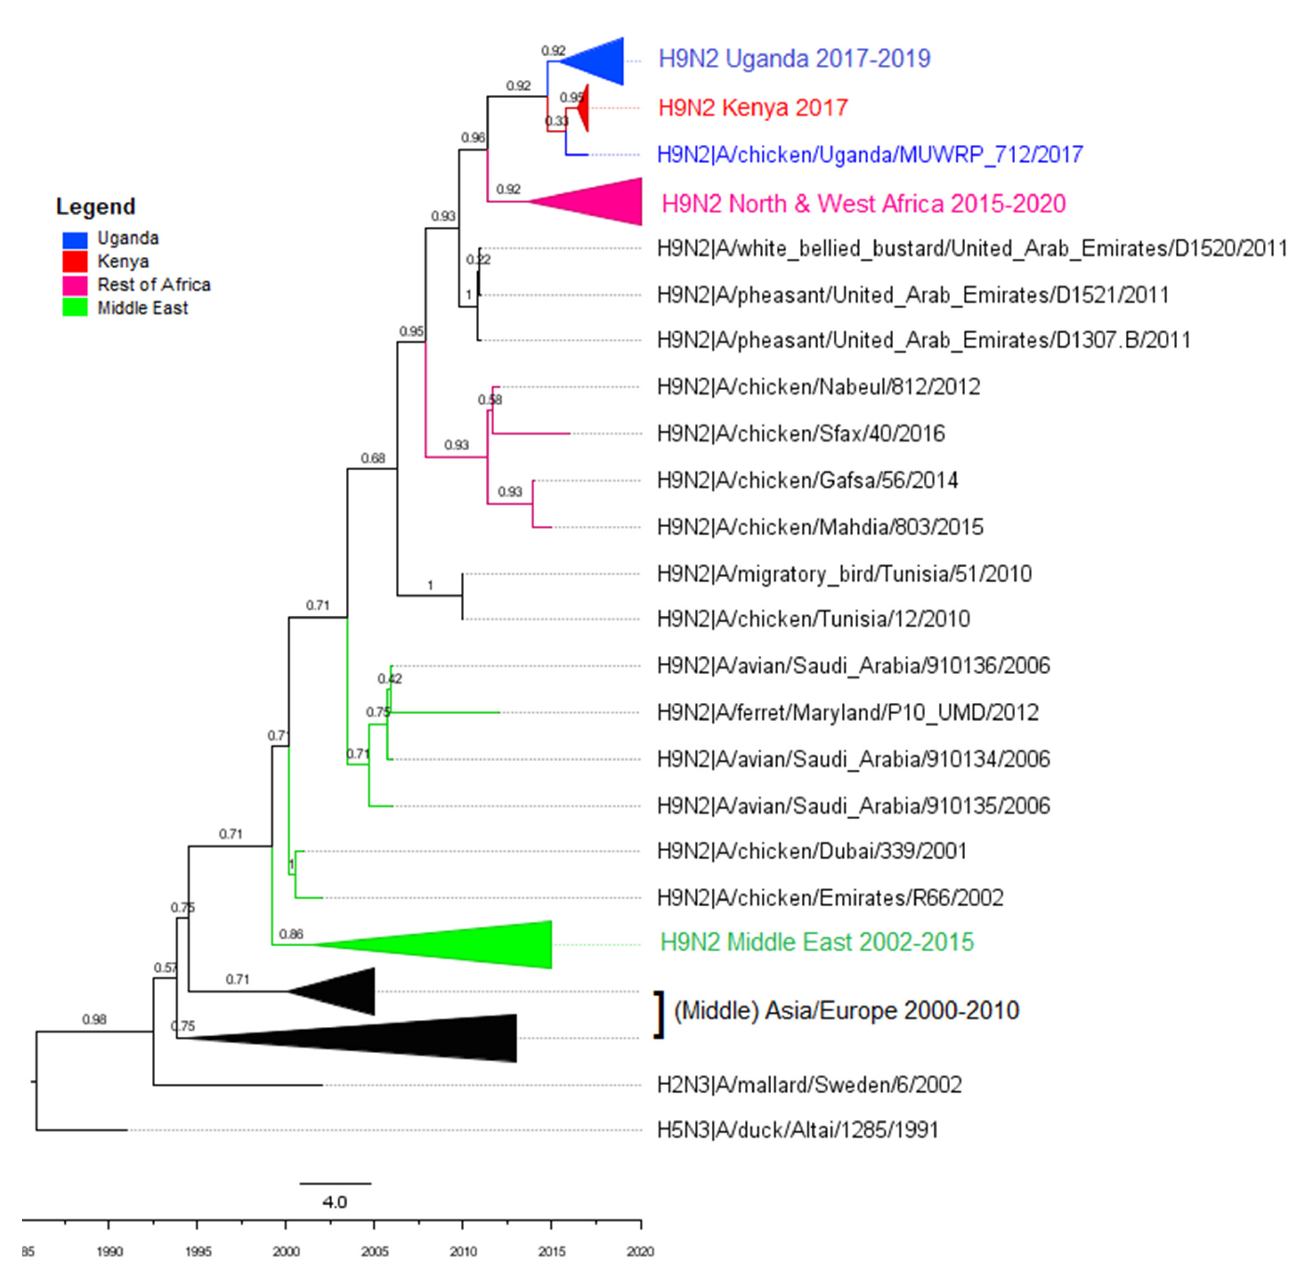
Figure A3. Phylogenetic tree for PA. Ugandan viruses are highlighted in blue, Kenyan in red, North and West African countries in pink, and the Middle East in the green clade Including various non H9N2 viruses from Asia and Europe tMRCA for Uganda is September 2014. Posterior probabilities are shown on the branches. Scales represent substitutions and time.